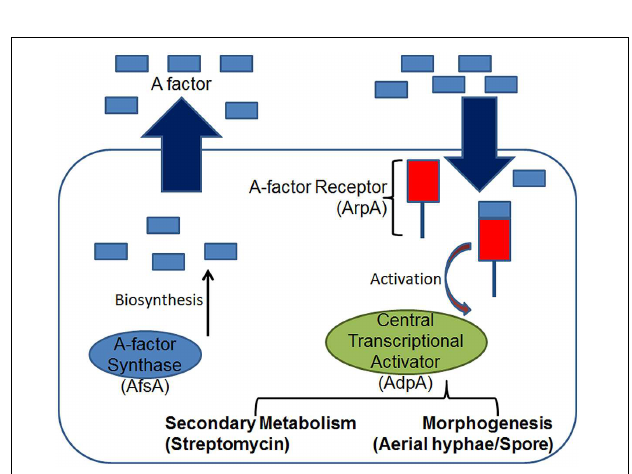
FIGURE 4 | The S. griseus A-factor regulon. Similar to Gram-negative bacteria, at threshold concentrations the diffusible A-factor (a γ -butyrolactone) binds the intracellular receptor ArpA and activates expression of the transcriptional activator AdpA which in-turn regulates multiple phenotypes either indirectly via a multi-step cascade, such as the development of aerial hyphae and sporulation, or directly, such as the production of secondary metabolites like